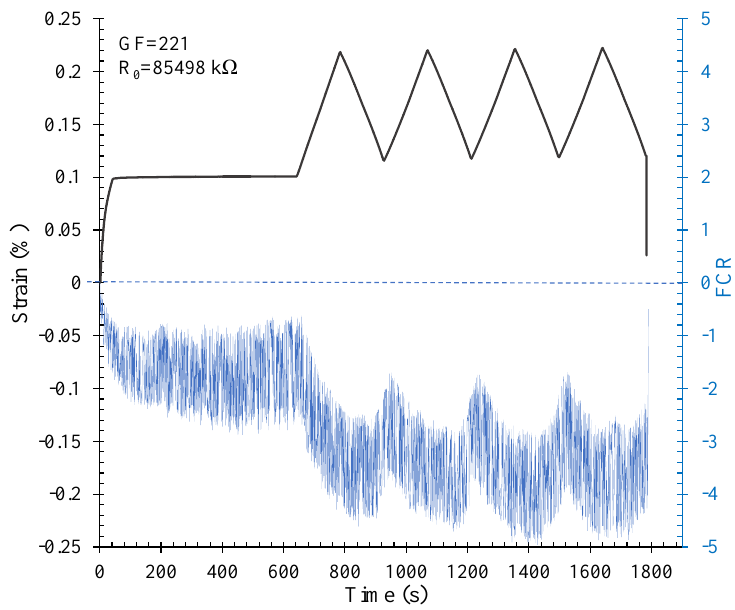
Figure 17. Piezoresistivity response of the cubic specimen under compression cyclic loading.